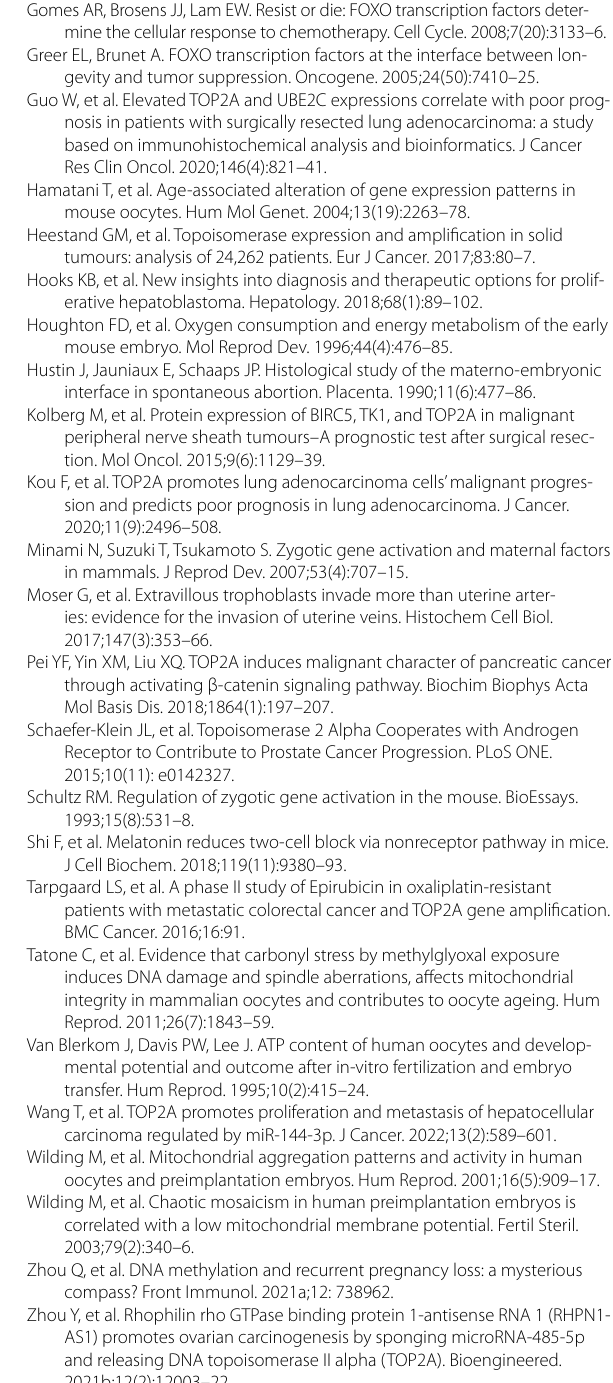
signalling pathway. Figure S2 . GO analysis of up-regulated and down- regulated differential genes Acknowledgements Not